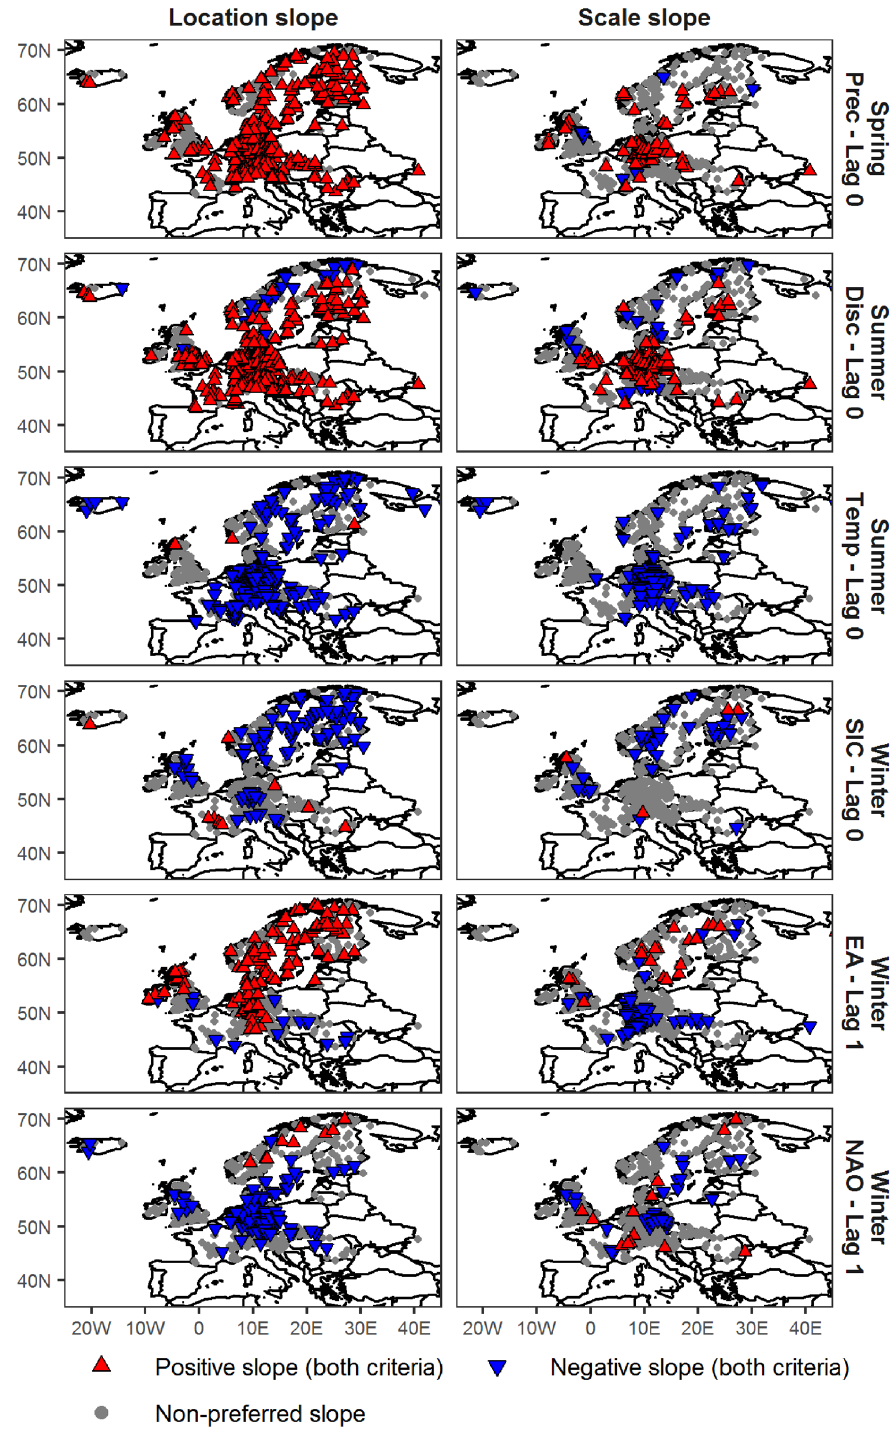
Figure 3. Spatial patterns of preferred climate-informed models for GEV location and scale for selected combinations of seasons, covariates and lead times. Preferrence is determined by two criteria: lower DIC value and the 90% credibility interval of the slope for the specific GEV parameter does not contain the zero value. Grey circles show gauges where no effect is found on the location (left) or scale (right) slope. Triangles show gauges where the examined covariate has an influence on the respective GEV parameter. Upward/red (downward/blue) triangles show positive (negative) association between season-ahead covariate and GEV parameters. The figure was created using the R package ggplot2, version 3.2.0. Country borders source: https:// thema ticma pping.